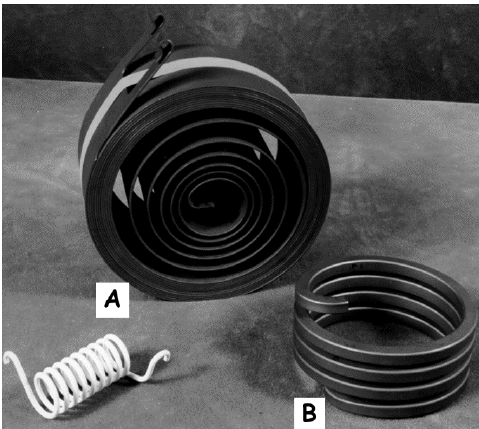
Figure 9. Titanium aircraft springs. Spring A is a door counterbalance clock spring fabricated from Ti-15-3-3-3 strip. Spring B is a coil spring made from square β -C wire for a launch bar power unit spring for the T-45 Trainer.